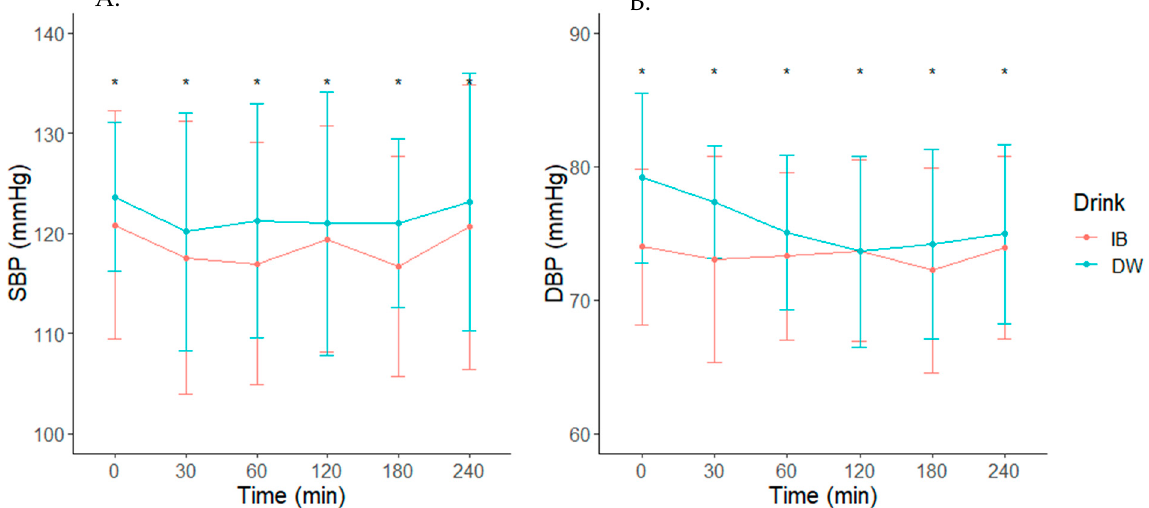
Figure 3. ( A ) Systolic blood pressure (SBP) and ( B ) Diastolic blood pressure (DBP) following consumption of the isotonic beverage (IB) or distilled water (DW). * Denotes a significant main effect of Drink, p < 0.05.